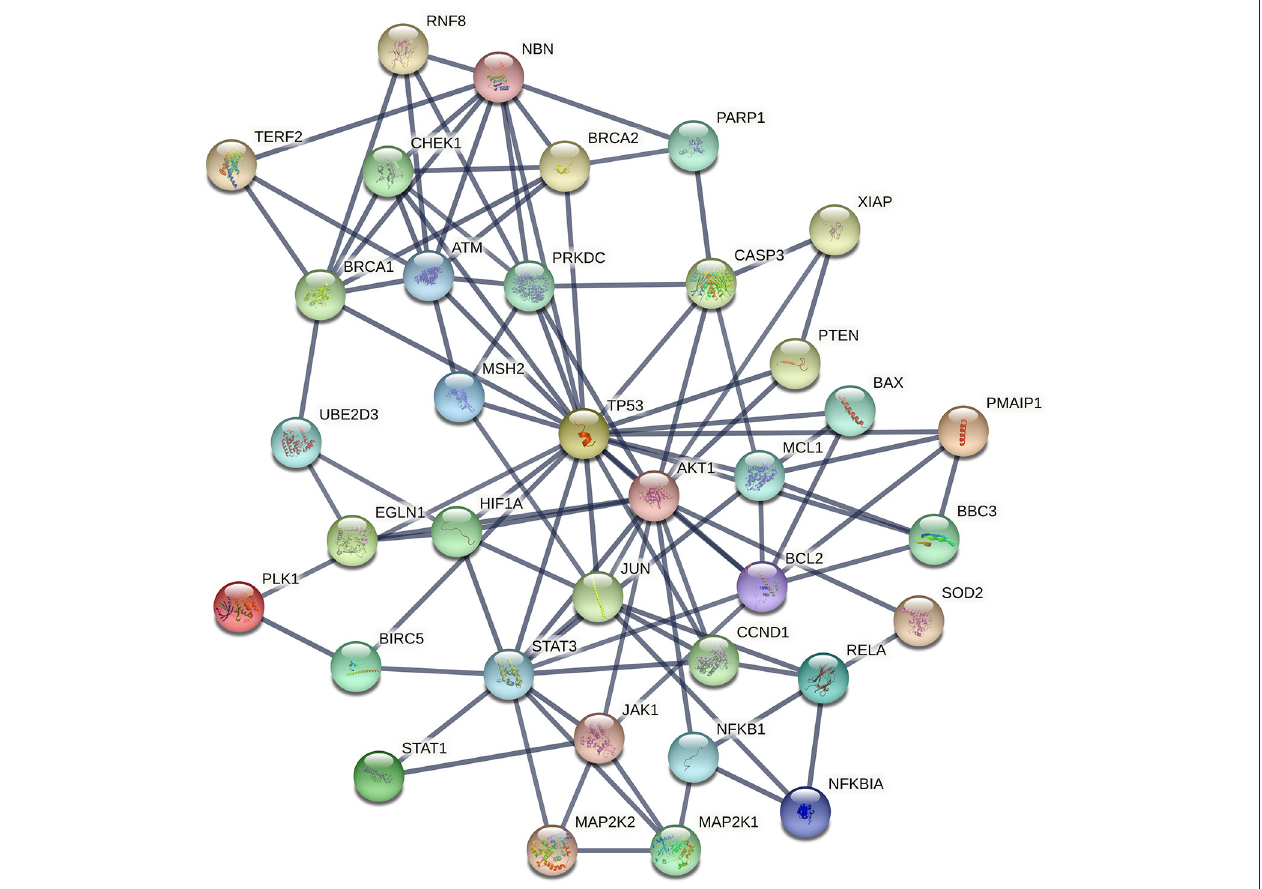
FIGURE 5 | STRING interaction network of the products of the 36 radiogenes. The nodes represent proteins and the edges indicate different modes of interactions with a confidence score ≥